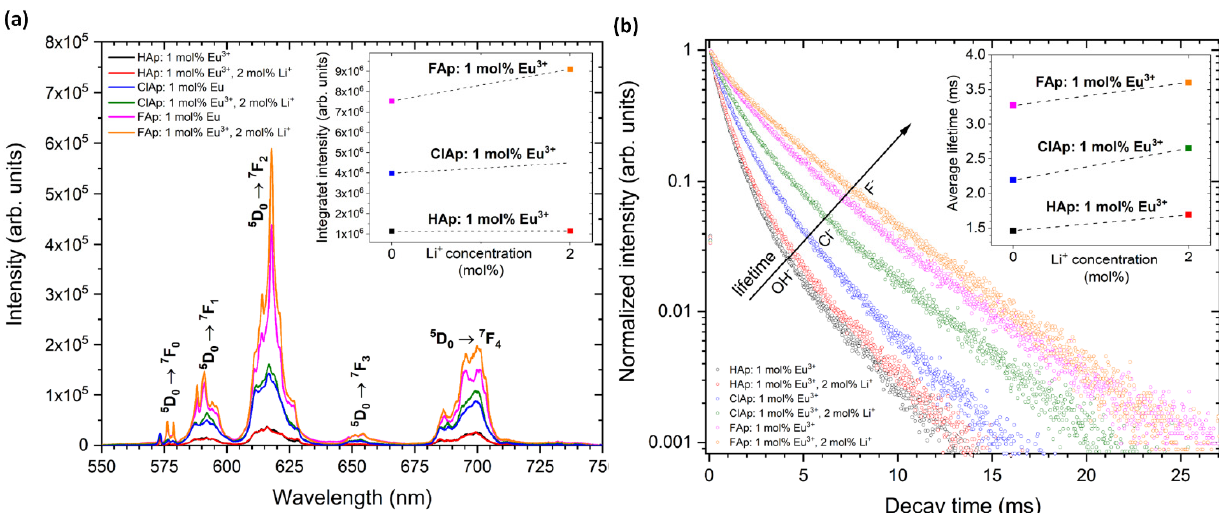
Figure 8. Emission spectra ( a ) of Ca 10 (PO 4 ) 6 (OH) 2 , Ca 10 (PO 4 ) 6 Cl 2 , Ca 10 (PO 4 ) 6 F 2 doped with 1 mol% Eu 3+ as well as co-doped with 1 mol% Eu 3+ and 2 mol% Li + ions under 395 nm excitation with the indication of 5 D 0 → 7 F J transitions in the range of 550–750 nm, detected at 300 K. The inset shows integral intensity of Eu 3+ emission as a function of the Li + ions’ concentra- tion. Decay profiles ( b ) of Eu 3+ ions in different types of apatite matrix, monitored at 618 nm according to the most intense electric dipole transition ( 5 D 0 → 7 F 2 ) . The inset shows the average lifetimes of Eu 3+ ions as a function of the Li + ions’ concentra- tion.